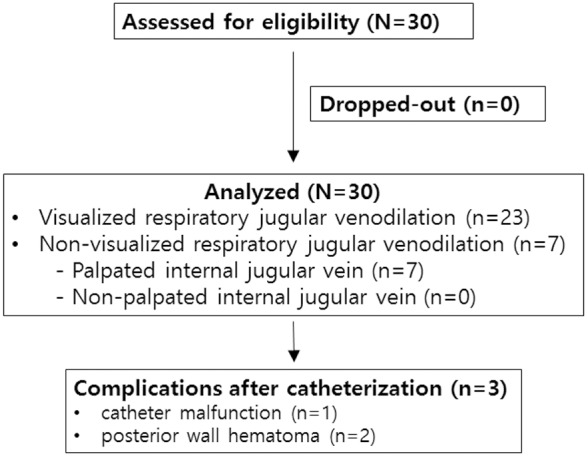
CONSORT flow chart.